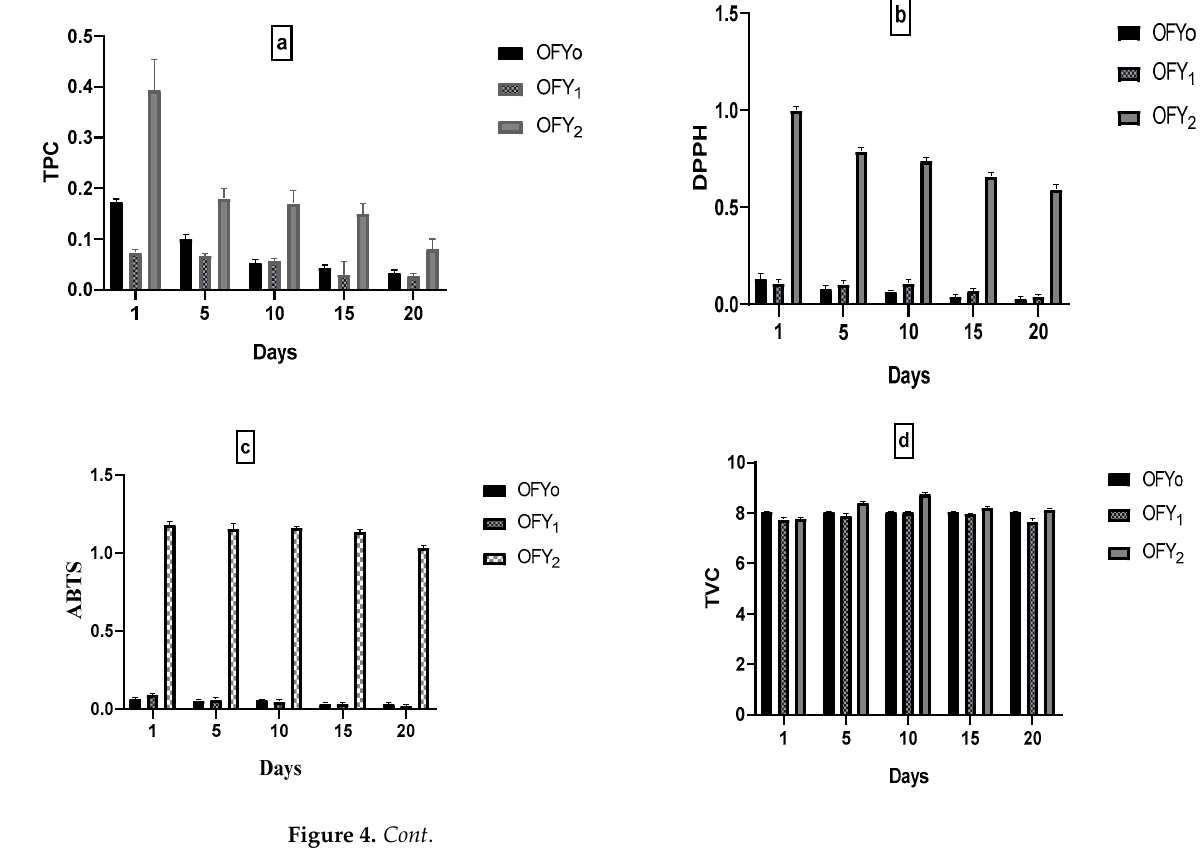
Table 2. Color properties of simple yogurt (OFYo), yogurt with probiotic (OFY 1 ), and okara fortified yogurt (OFY 2 ).